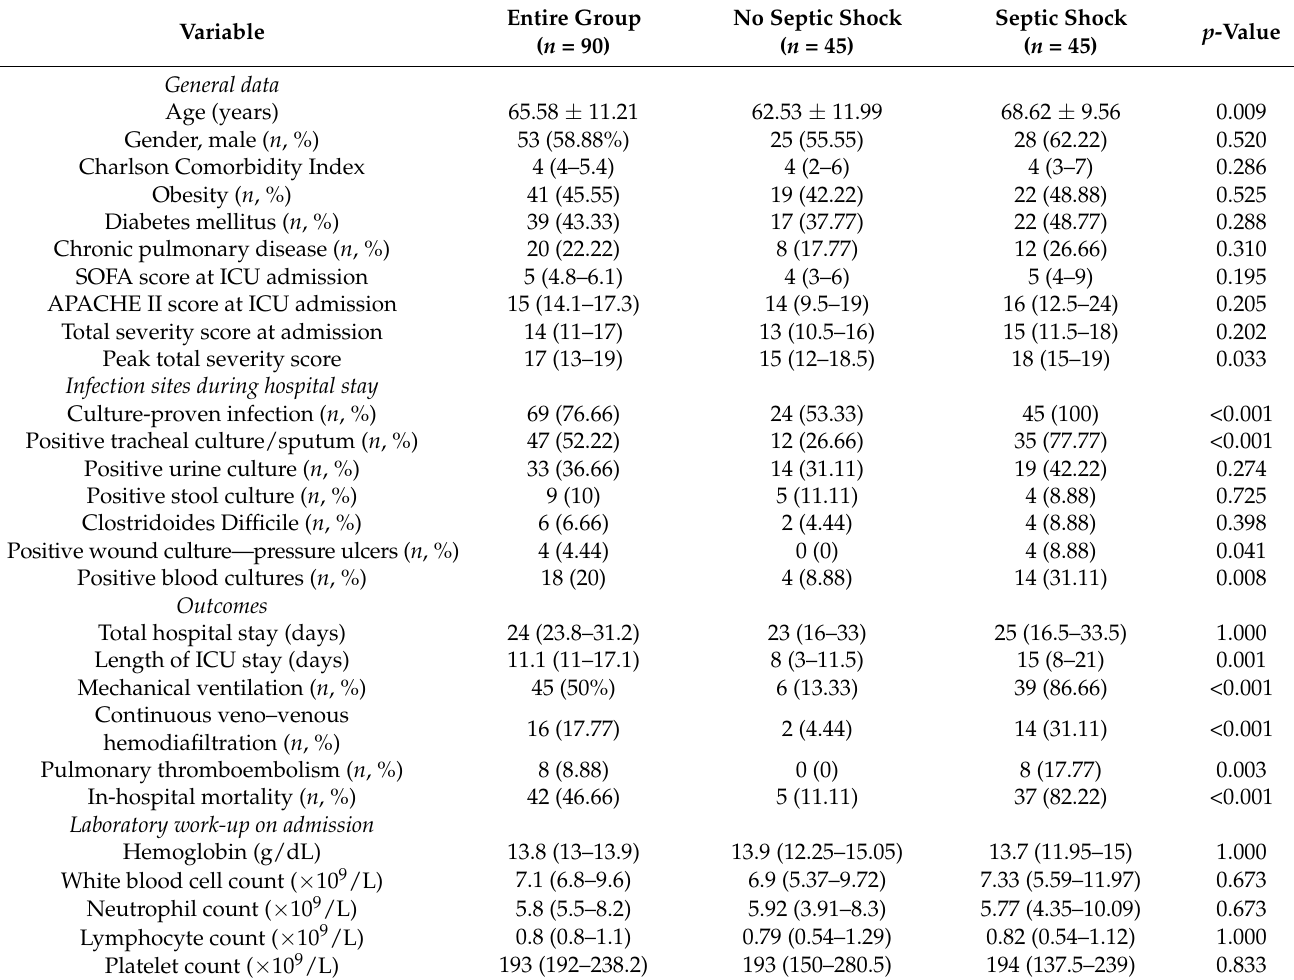
Table 1. Baseline characteristics and group